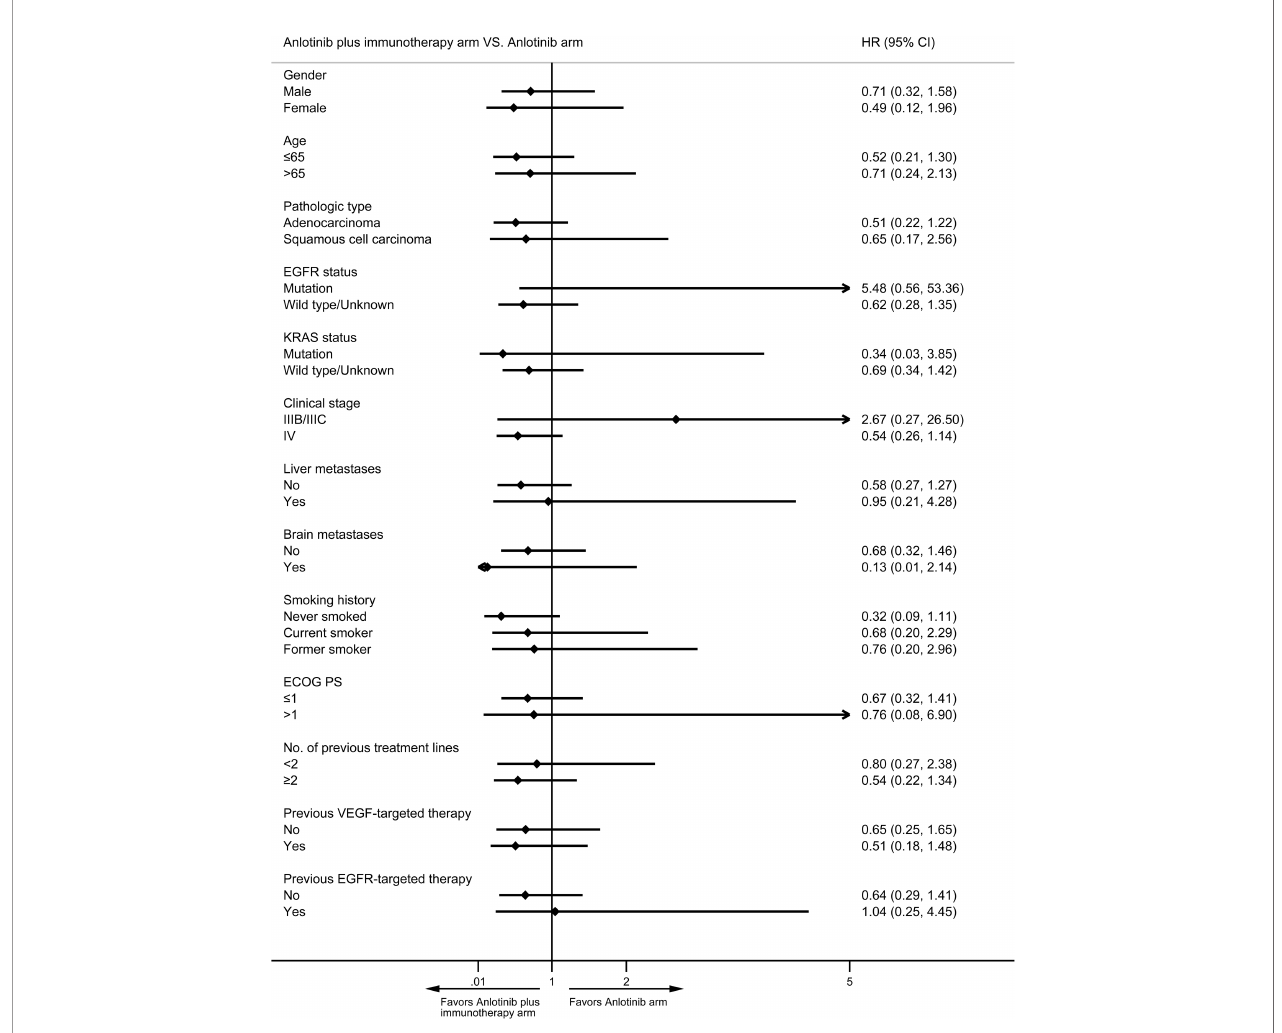
FIGURE 5 | Forest plot of strati fi cation analysis of PFS between patients in anlotinib arm and anlotinib plus immunotherapy